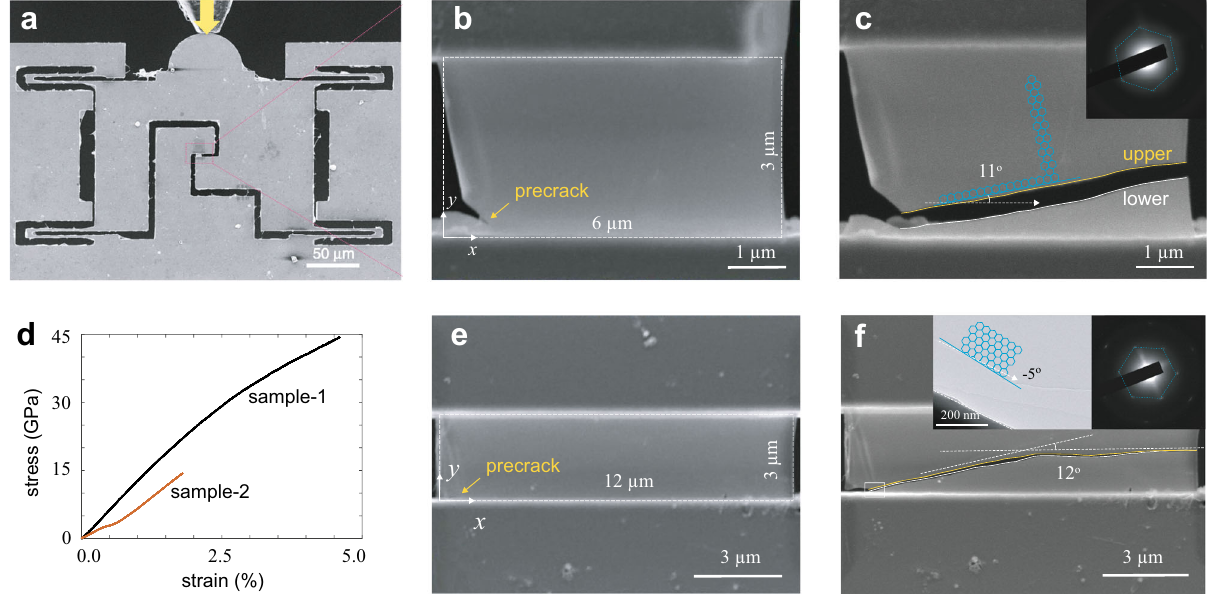
Fig. 1 In situ SEM tensile testing of single-crystalline graphene monolayers. a Experimental setup. Samples were placed on a push-to-pull (PTP) micromechanical device, which is actuated by an external quantitative pico-indenter 15 . b , c SEM images of Sample 1 at the initial ( b ) and fractured ( c ) states in the fi nal loading-unloading cycle. d Stress-strain relations of Sample 1 (black) and Sample 2 (red), showing the brittle fracture features. The apparent nonlinearity arises mostly from the presence of cracks due to the limited size of samples. e , f SEM images of Sample 2 at the initial ( e ) and fractured ( f ) states in the fi nal loading-unloading cycle. The dimensions and coordinates are measured on the initial state. The cleaved (upper and lower) edges along the crack paths (from left to right) were marked in ( c ), ( f ). The crystalline direction is characterized by TEM and shown in the insets of panels ( c ), ( f ). Panels ( c ), ( f ) show the non-planar or curling nature of the cleaved